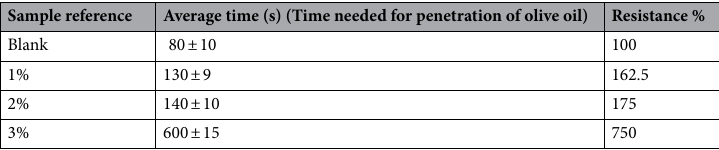
Table 4. Resistance of uncoated and coated HSP with EDCFs for olive oil penetration.